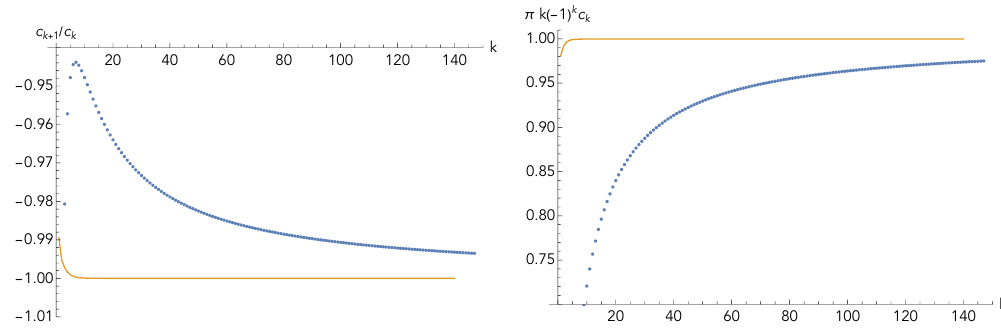
Figure 1 . tr M ratio test. On the left, we show in blue the ratio c k +1 /c k that tends to − 1 . The orange line is obtained after applying a 5th order Richardson acceleration. On the right, we present the same analysis for the Darboux indicator πk ( − 1) k c k